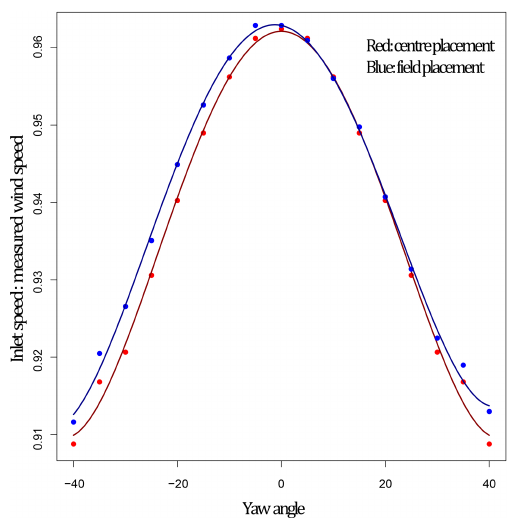
Figure 5. Empirical correction factors for field placement (blue) and centred placement (red) fitted with a weighted polynomial re- gression.